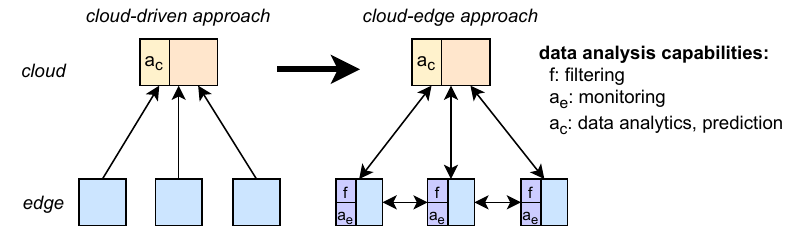
Figure 11. Balancing intelligence among edge and cloud computational